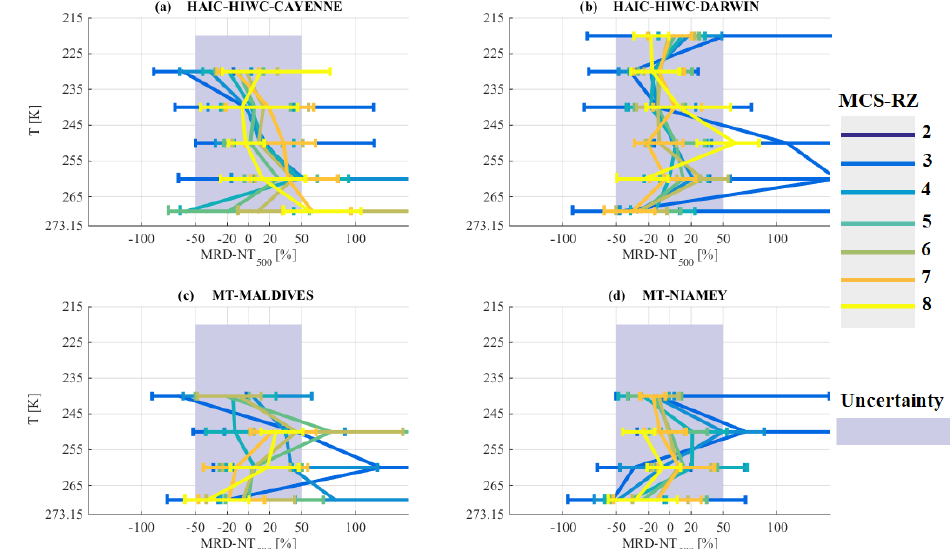
Figure 12. The same as Fig. 6 but for MRD-NT 500